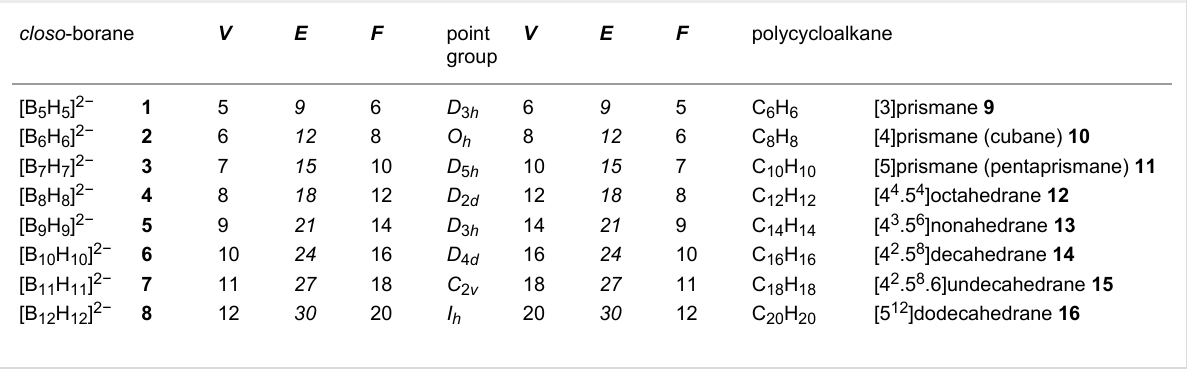
Table 1: Corresponding closo -boranes and polycycloalkanes of the same symmetry. closo